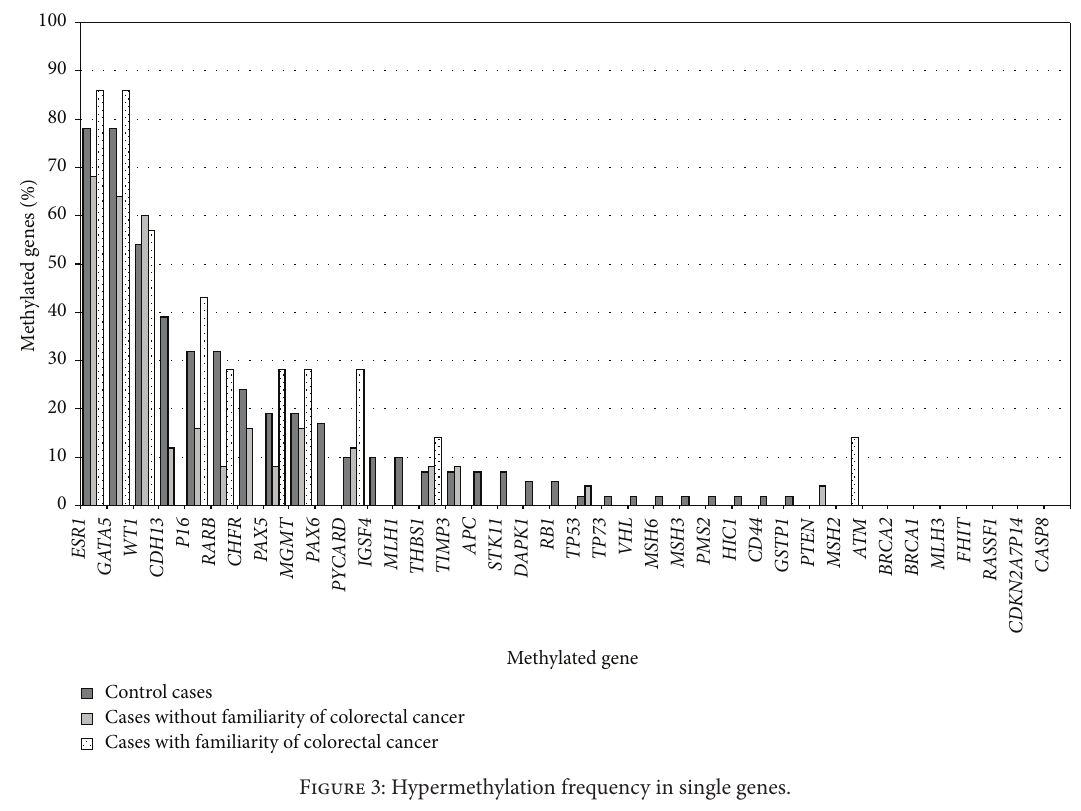
Figure 3: Hypermethylation frequency in single genes.